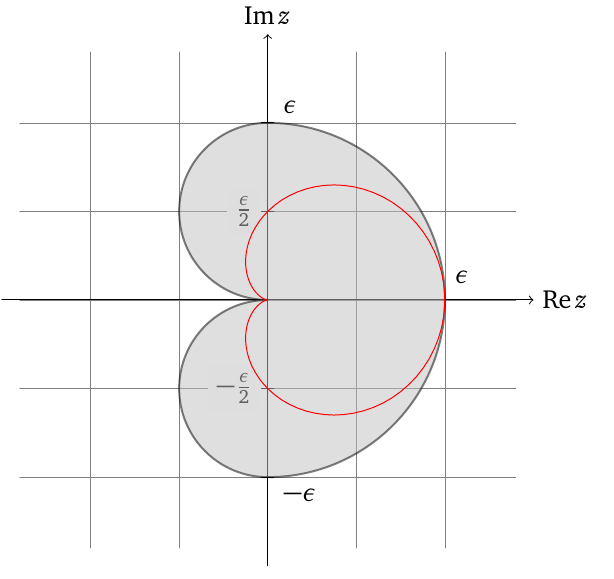
Figure 13: In gray, the domain Ω ε of Definition 6.9. In red, the cardioid ρ = ε cos 2 ( θ ) 2